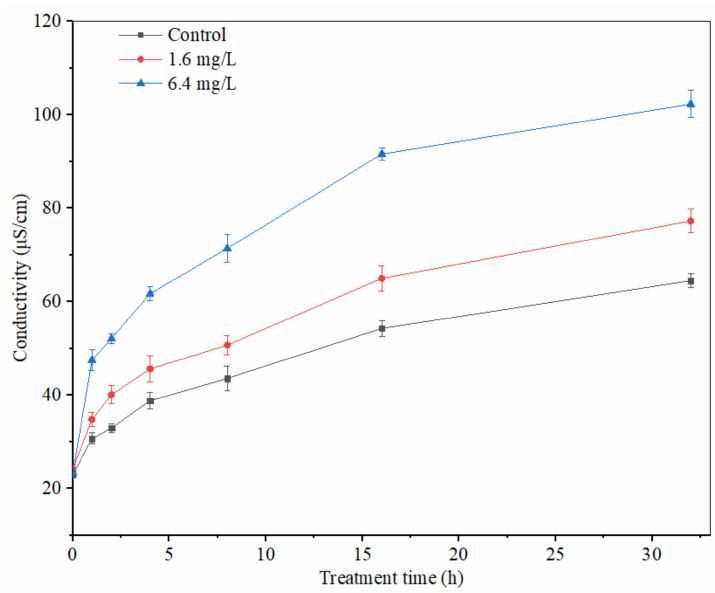
Figure 9. Effect of anti-fungal peptides on mycelium extracellular conductivity of A. carbonarius